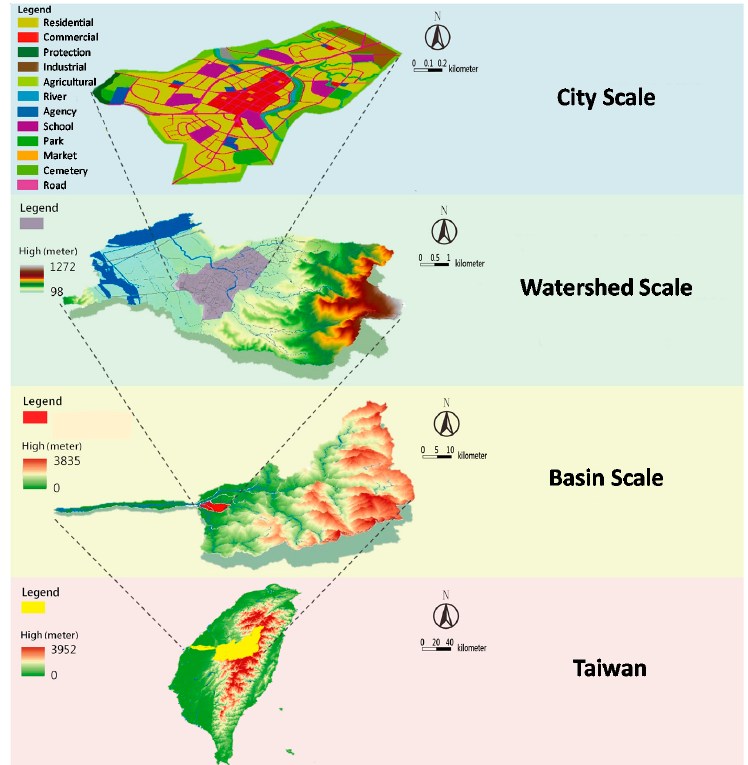
Figure 1. Study areas on different scales.